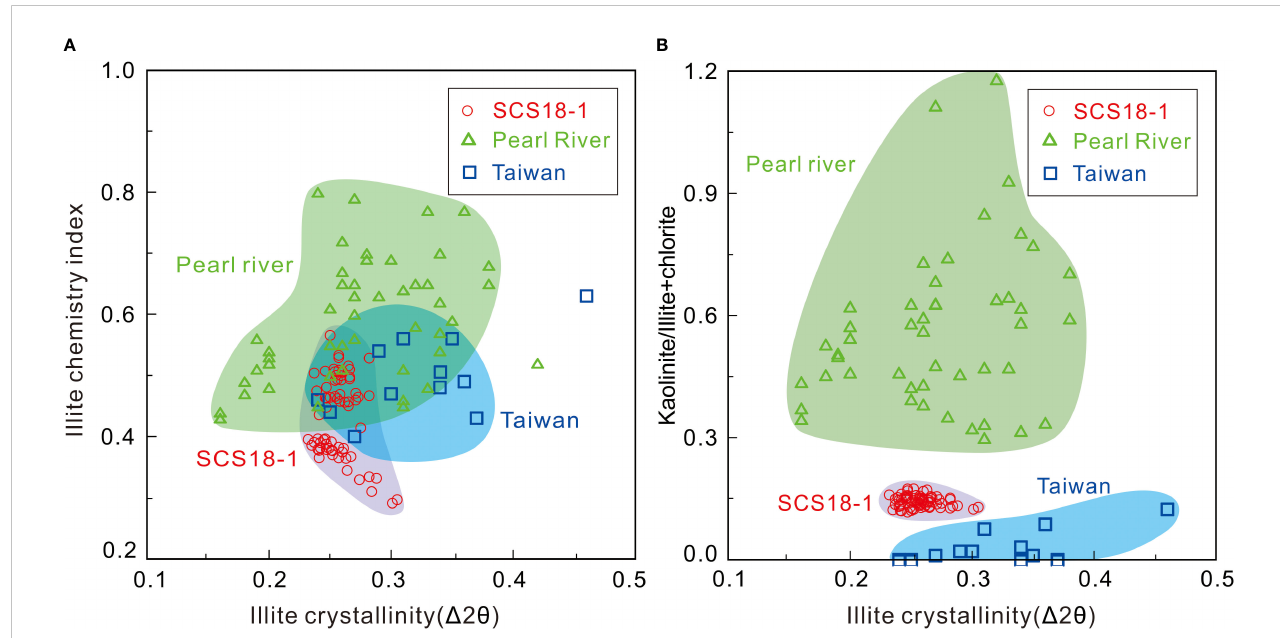
FIGURE 7 Correlation of illite crystallinity with the (A) illite chemical index and (B) kaolinite/illite+chlorite ratio in argillaceous sediments from core SCS18-1. River sediments from Taiwan rivers (Li et al., 2012), the Pearl River (Liu et al., 2007), and Luzon (Liu et al., 2009); the referenced data have been converted according to Biscaye